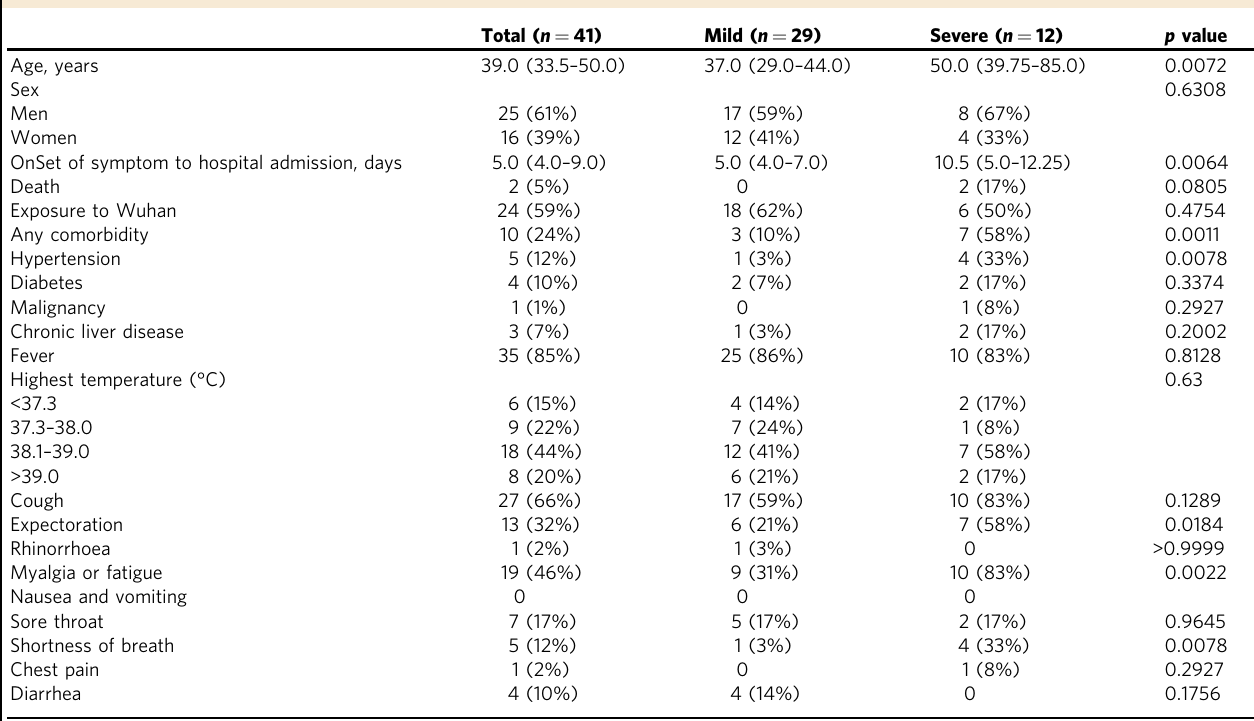
Table 1 Demographics and baseline characteristics of patients infected with